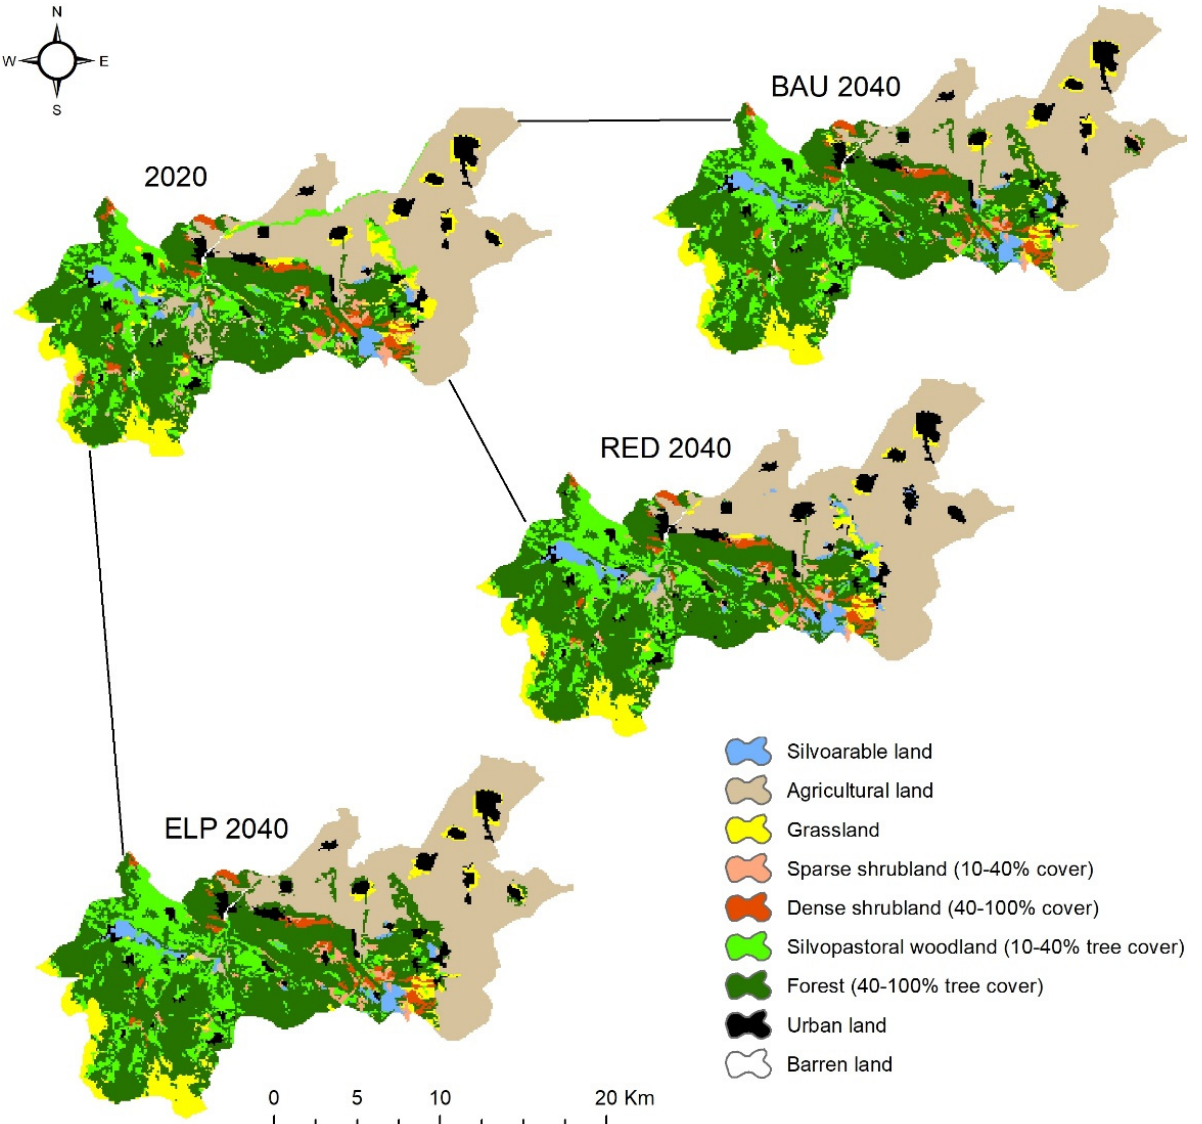
Figure 6. Forecast map of the landscape changes of Mouzaki for the period 2020–2040 (all forecast scenarios), after CLUE-S.